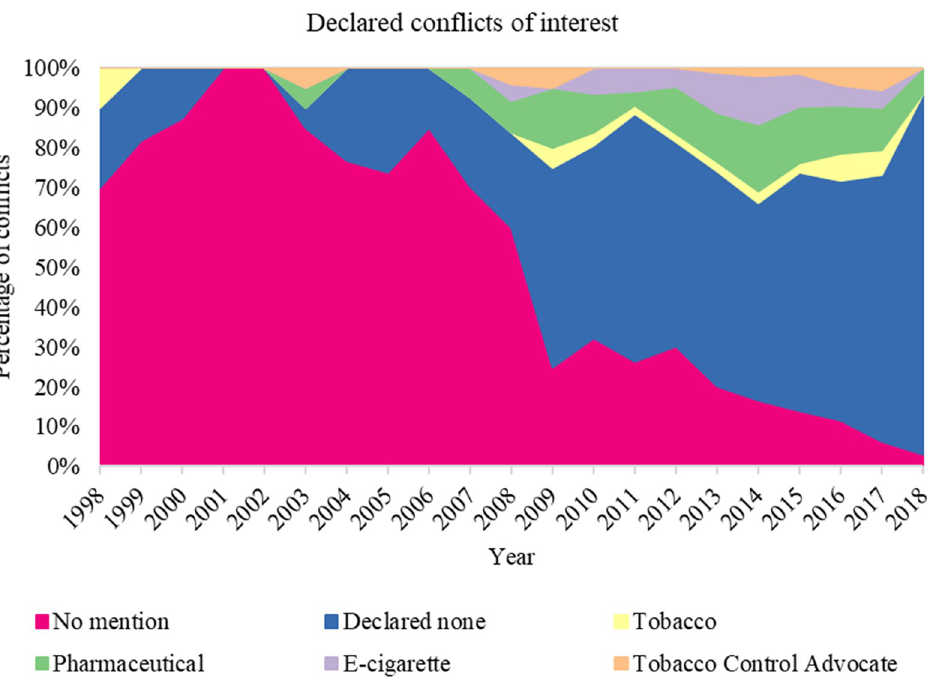
Fig 6. Percentage of declared conflicts of interest across citations between